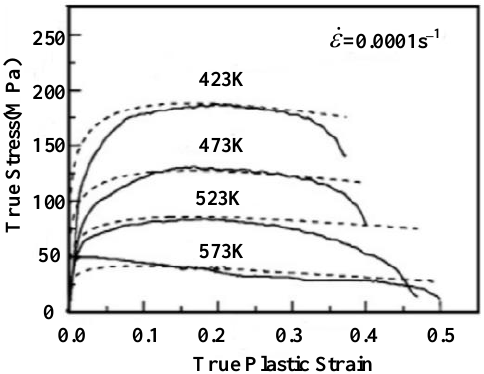
Figure 12. The stress prediction results of AZ31 magnesium alloy based on the modified FB model [23].